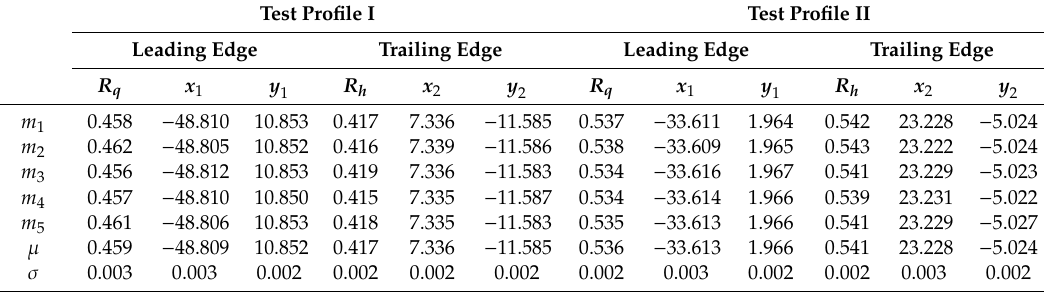
Table 2. Measurement results of the leading and trailing edges (unit: